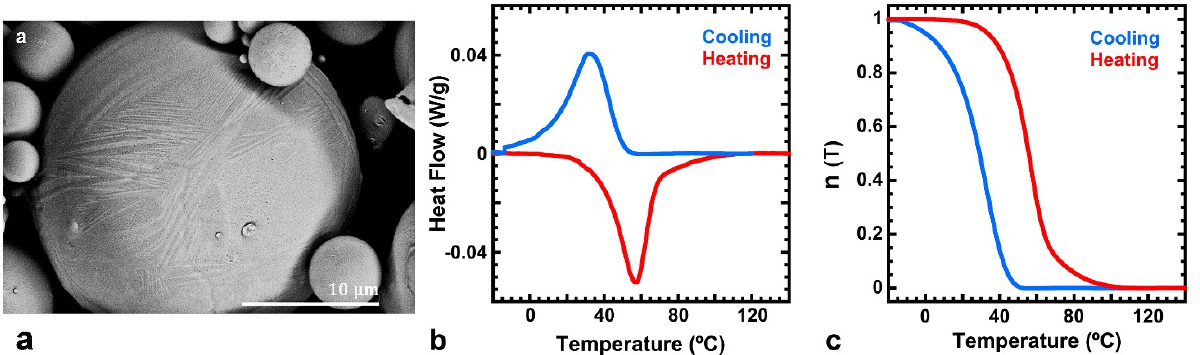
Figure 2. ( a , b ) SEM–SE images of the SMA powder showing different sizes of particles with a diam-